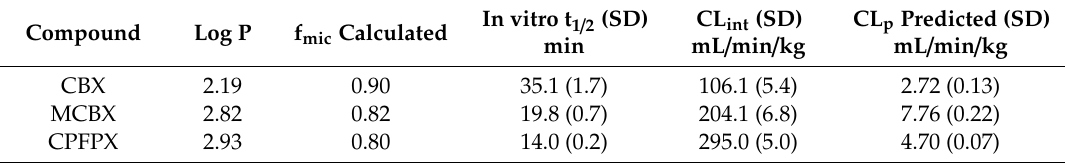
Figure 2. Representative depletion-time profiles of CPFPX (triangles), CBX (squares) and MCBX (circles) in rat liver microsomes. Data were fitted to a monoexponential model (solid lines). Table 1. Metabolic stability of the xanthine A 1 AR ligands in rat liver microsomes and predicted plasma clearance (CL p ). Experiments were conducted in triplicate. f mic , unbound fraction in microsomes; CL int , intrinsic clearance; SD, standard deviation.